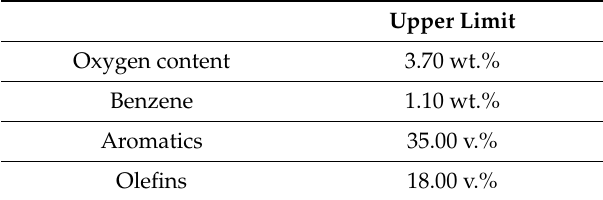
Table 5. Specifications for gasoline based on European Union